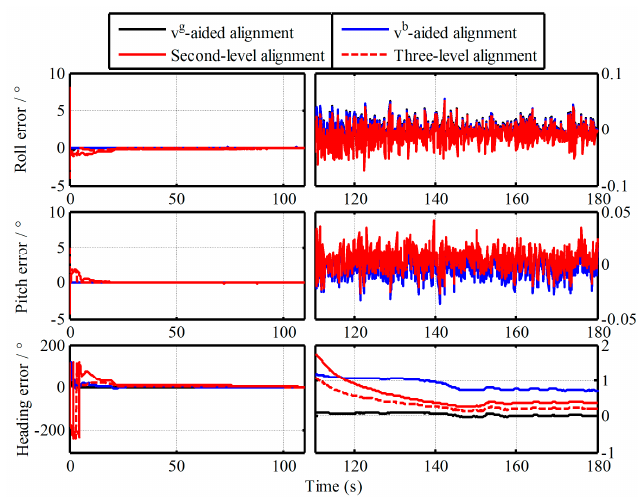
Figure 11. Alignment results of vehicle experiment.